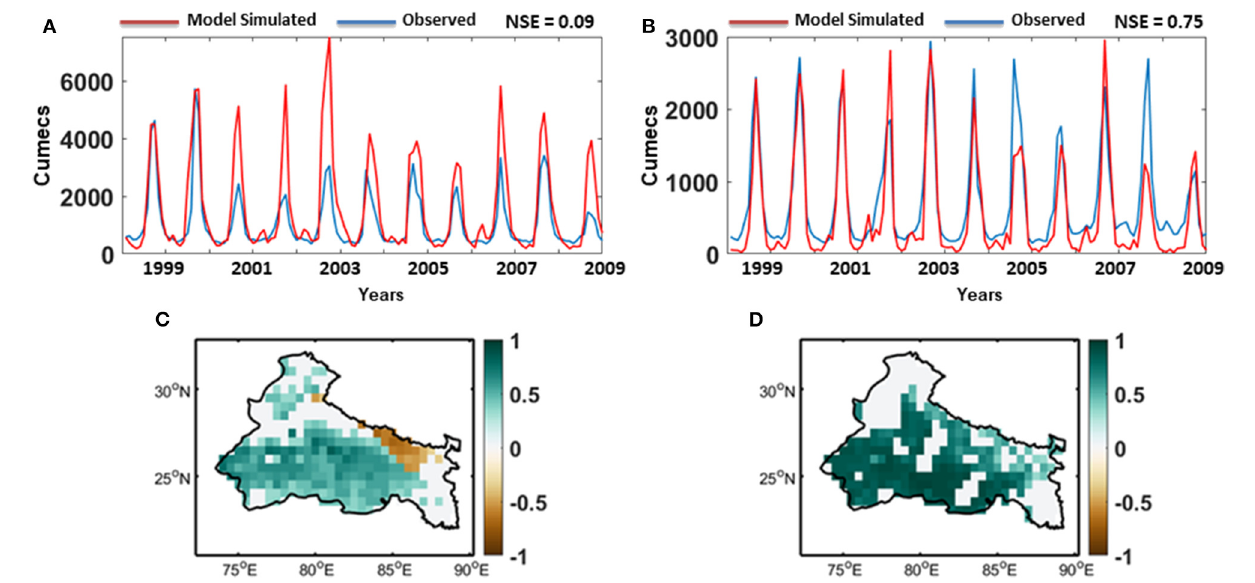
FIGURE 4 | Calibration and Validation of hydrologic model VIC. (A) Time series of monthly observed (blue) and model simulated (red) streamflow at Ankinghat station. (B) Time series of monthly observed (blue) and model simulated (red) streamflow at Bhimaghoda station. (C) Correlation of observed and model simulated evapotranspiration during JJAS season at 95% significance level. (D) Correlation of observed and model simulated soil moisture during JJAS season at 95% significance